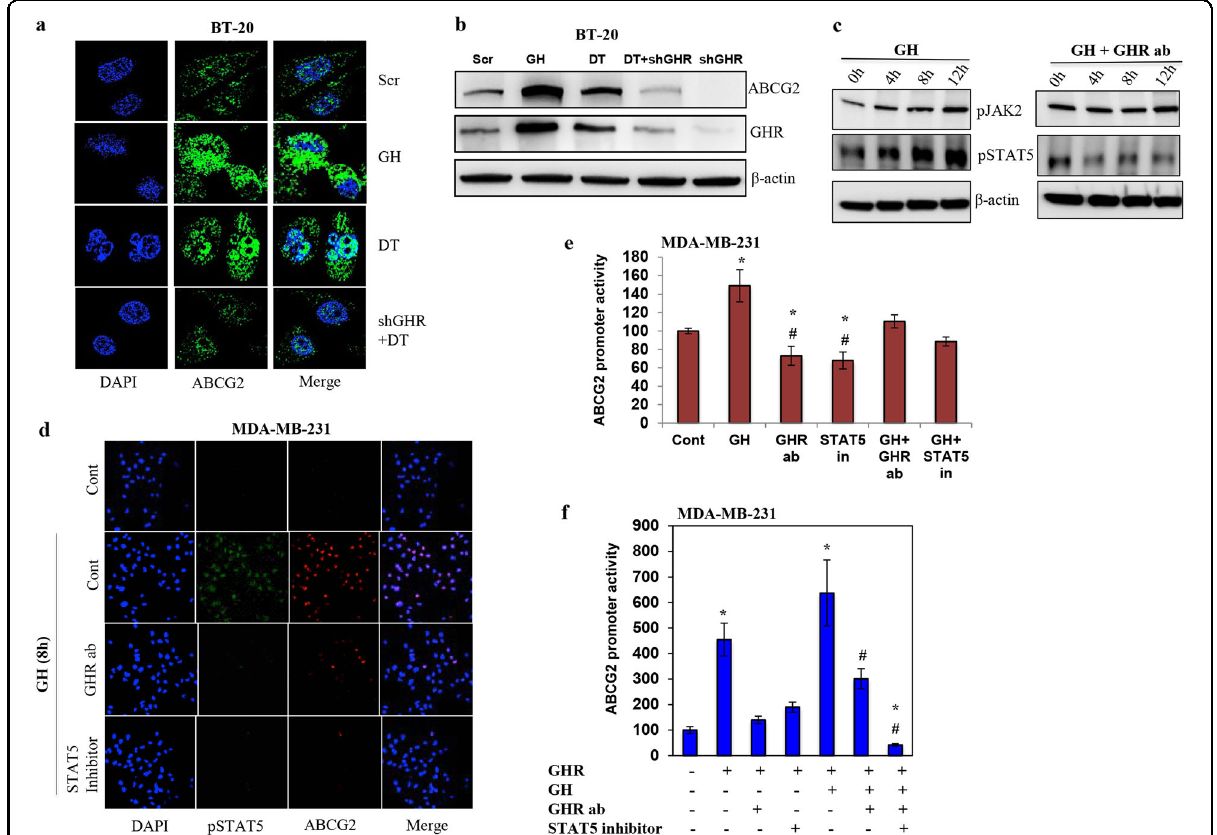
Fig. 4 GHR activation increases ABCG2 expression through JAK2/STAT5 signaling. a and b Cells were treated with GH, DT, or shGHR + DT and probed with ABCG2 primary antibody and Alexa Fluor 488-conjugated secondary antibody. Representative images of ABCG2 expressions in BT- 20 cells are shown ( a ) immuno fl uorescence and ( b ) Western blot. c Phosphorylated JAK2 and STAT5 levels analyzed by Western blot. d Immuno fl uorescence at 8 h after GH treatment showed decreased levels of pSTAT5 and ABCG2. e GHR blocking or STAT5 inhibition reduced ABCG2 promoter activity. MDA-MB-231 cells transfected with ABCG2 promoter plasmid were treated with GH alone, GHR blocking antibody, or STAT5 pharmacological inhibitor for 24 h. GHR antibody treatment and STAT5 inhibition reduced the GH induced ABCG2 luciferase promoter activation. f GHR overexpression drastically increased the ABCG2 promoter activity. MDA-MB-231 cells stably overexpressing GHR was treated with GH and GHR soluble antibody or STAT5 inhibitor for 24 h and ABCG2 promoter activity was measured. The experiments were repeated three times and the representative images were presented in case of Western blots and immuno fl uorescence experiments. ABCG2 promoter assay was repeated three times with fi ve replicates. *indicates p < 0.05 compared to respective control; # indicates a signi fi cant difference between GH and other